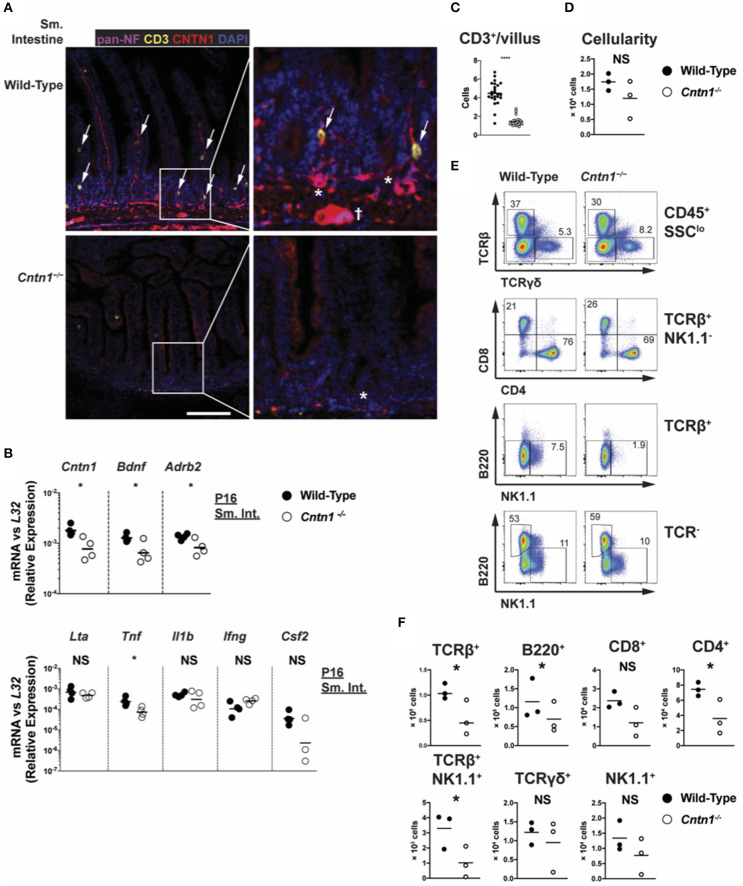
Cntn1 expression within intestinal villi and submucosal/myenteric plexus (A). Representative immunofluorescence images of P11 small intestine from wild-type (top panels) and Cntn1−/− (bottom panels) at 4 ×. Tissues were costained for pan-Neurofilament (magenta), CD3 (yellow), Cntn1 (red), and DAPI (blue). Composite images are shown at left with enlarged areas indicated at right. White scale bars represent 50 μm. arrows indicate CD3+ cells that are in contact with Cntn1+ neurons. * indicates submucosal plexus, dagger indicates myenteric plexus (B) Wild-type and Cntn1−/− P16 small intestine tissues were harvested for RNA and analyzed for the indicated genes by QRT-PCR. Graphs show transcript abundance relative to L32. Individual transcripts were compared by Student's t-test (C). The average number of CD3+ T cells divided by the average number of villi per visual field was quantified and graphed (D). Graph shows intestine cellularity from wild-type and Cntn1−/− animals (E,F). Representative FACS analysis of wild-type (left) and Cntn1−/− (right) P12/P13 intestinal lymphocytes. Total live intestinal lymphocytes analyzed for the frequency of αβ T cells (TCRβ+) and γδ T cells (TCRγδ+), CD4+ and CD8+ αβ T cells, NK1.1+TCRβ+ cells, natural killer cells (TCRβ−NK1.1+), and B cells (B220+) (E). The cellularity of each lymphocyte population is graphed in (F). Analysis of data by Student's t-test. NS, not significant; *p < 0.05; ****p < 0.0001.